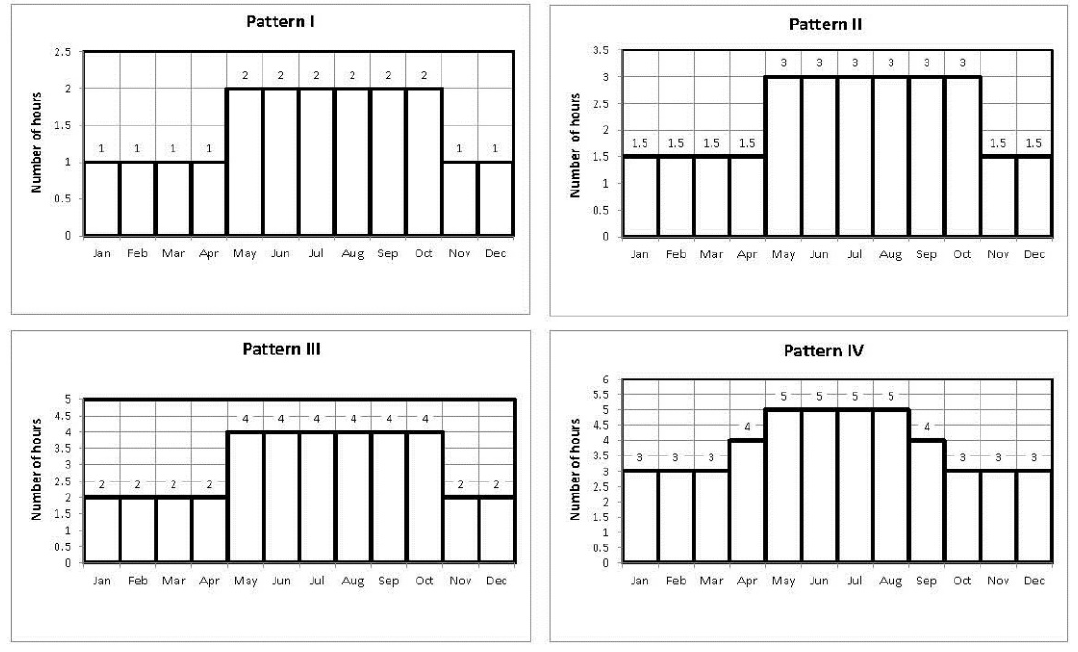
Figure 11. Patterns of irrigation duration.